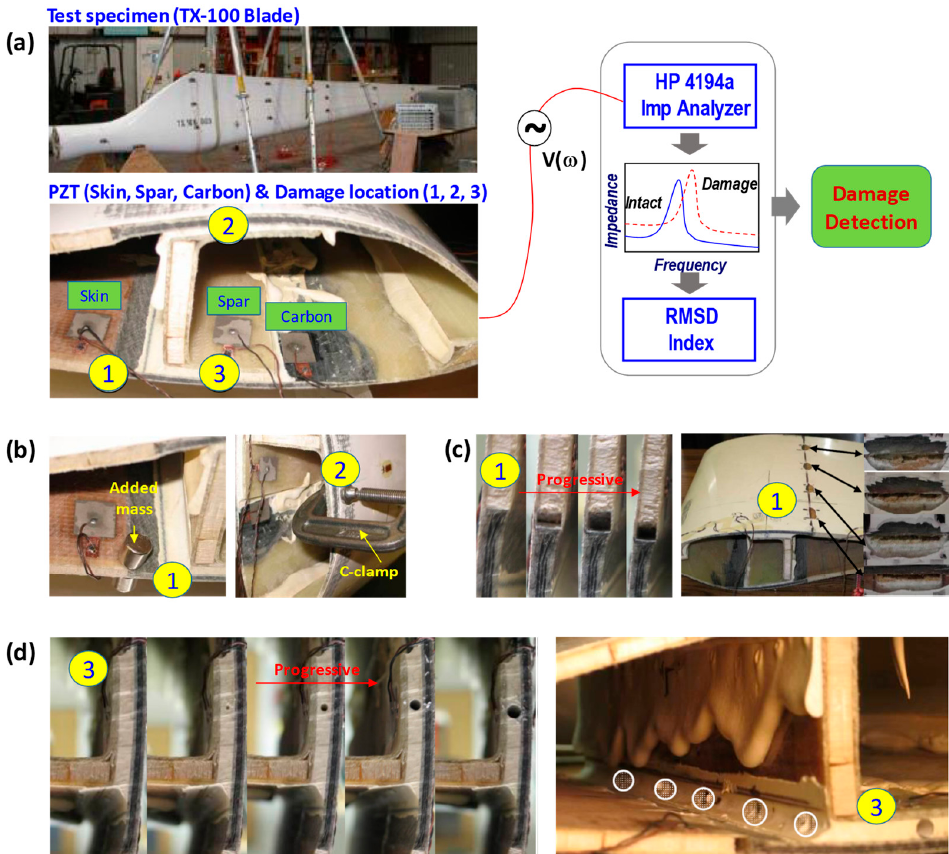
Figure 10. Detecting structural damages on the spar and the skin of a blade segment using the im- pedance-based technique [49] : ( a ) test specimen and procedure, ( b ) indirect damage testing, ( c ) and impedance-based technique [49]: ( a ) test specimen and procedure, ( b ) indirect damage testing, ( c ) and actual damage testing at location 1 and ( d ) at location 3. actual damage testing at location 1 and ( d ) at location